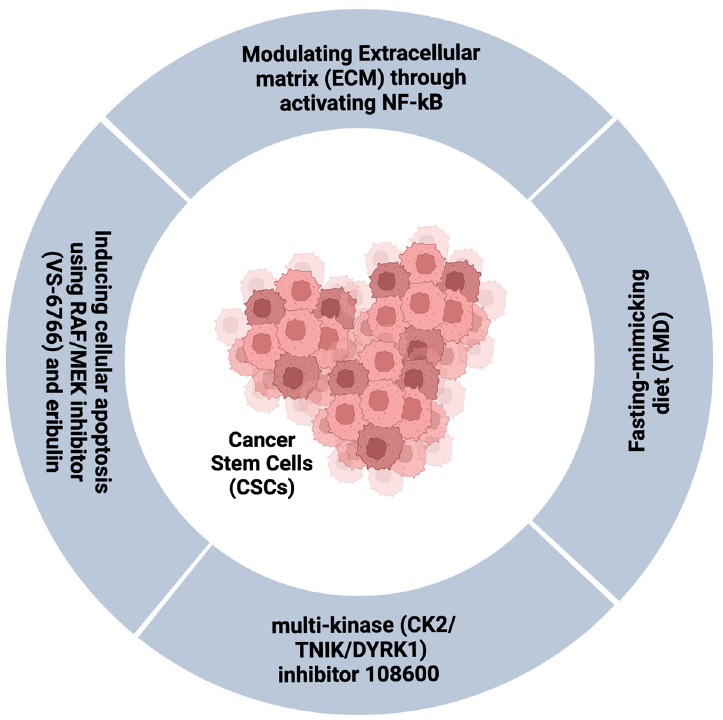
Figure 4. Therapeutic strategies to target CSCs in TNBC. Created with BioRender.com, agreement number IQ248V9PR7.